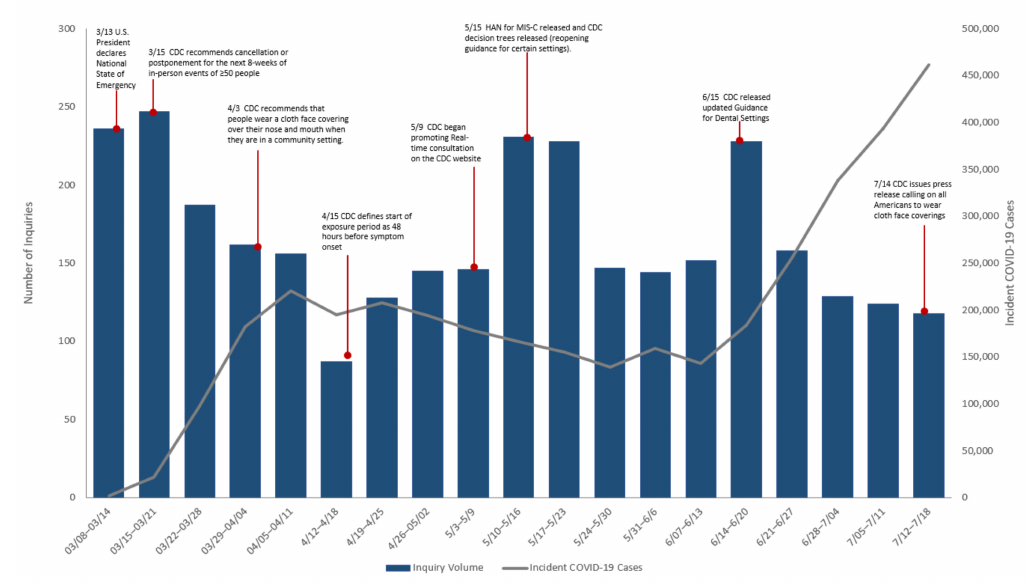
Figure 1. Weekly inquiries and COVID-19 incident cases—United States, 11 March–18 July